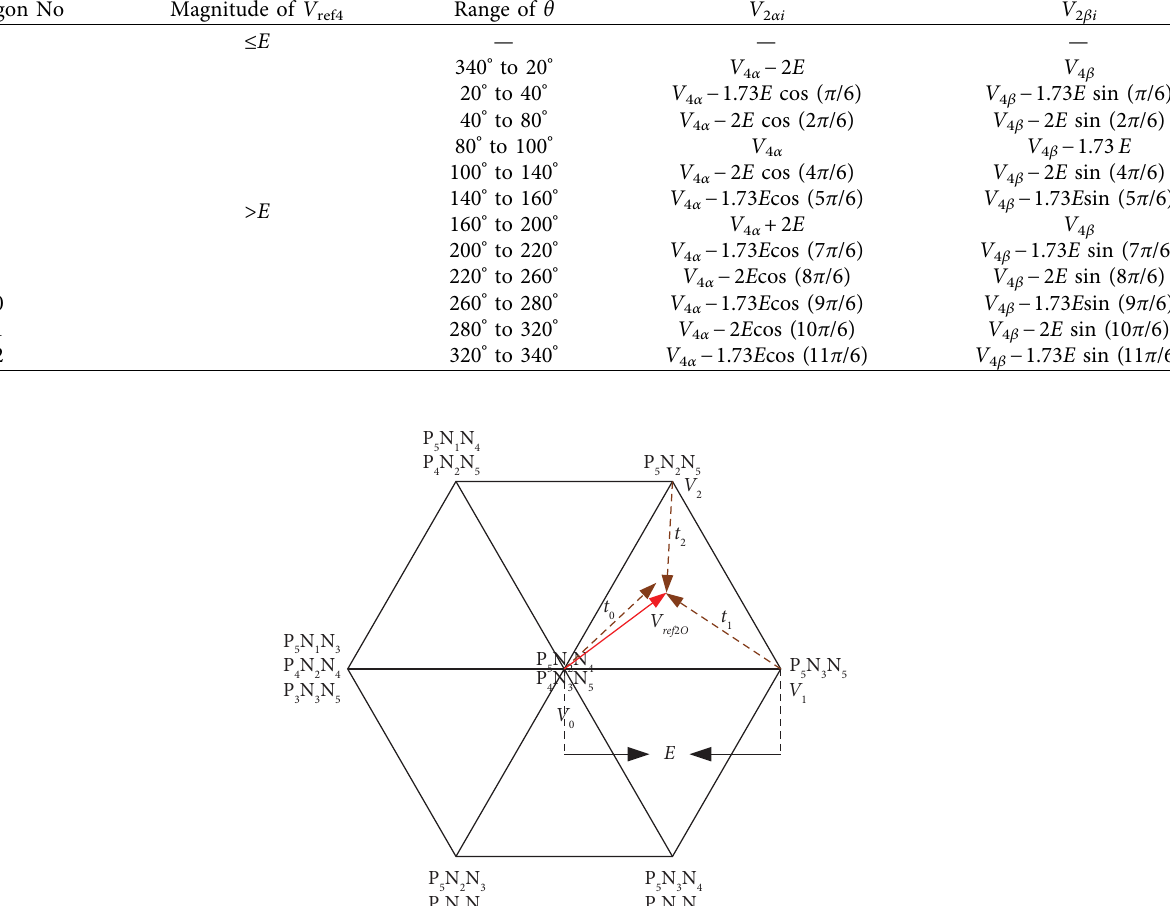
Table 5: Selection of 2L hexagons from 4L SVD and mapping of V Hexagon No Magnitude of V ref4